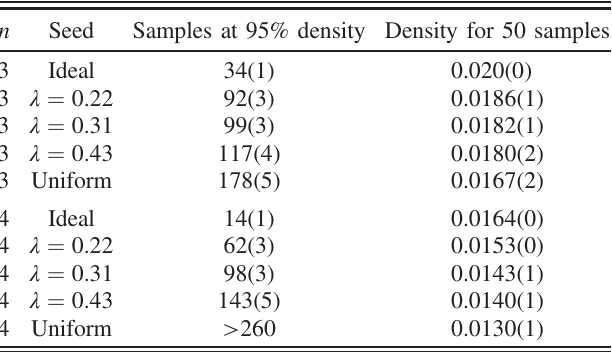
TABLE I. Subgraph search performance for different sources of random search seeds. The metrics shown are the number of samples needed to obtain a mean density of 95% and the density achieved when using 50